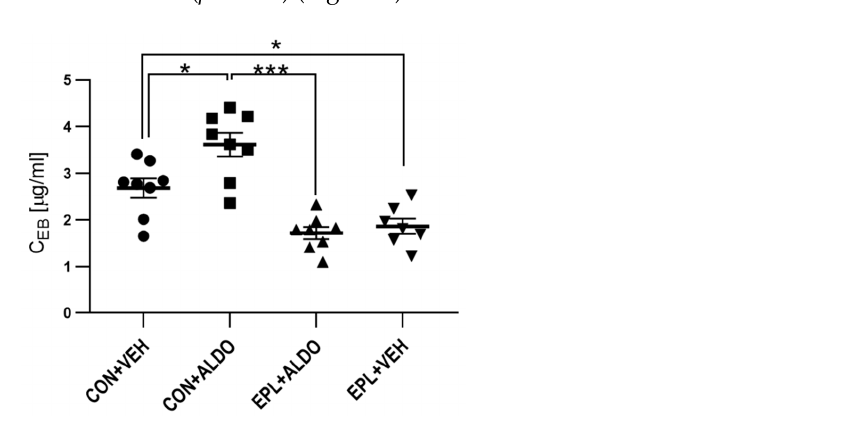
Figure 3. Changes in vascular permeability after acute EPL or IND administration. n = 7–8; n for each group is the number of skin samples, not the number of animals; 12 rats were used in this experiment; data are presented as mean ± SEM and individual values; ALDO—aldosterone; C EB — Evans blue concentration per gram of skin tissue; CON—5% gum arabic solution; EPL—eplerenone;